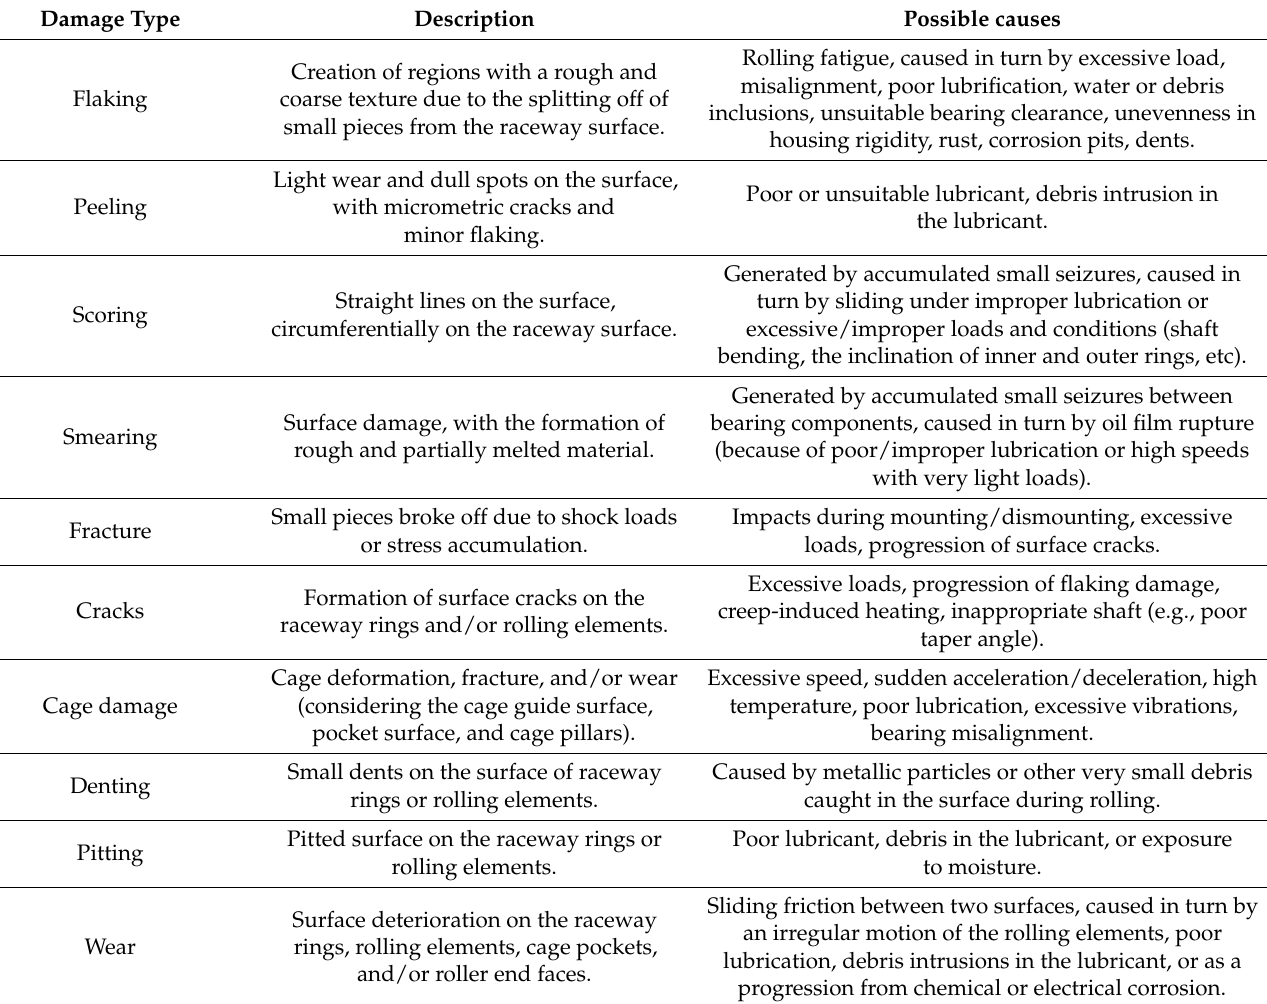
Table 2. Typical damage typologies in bearings, according to Ref.